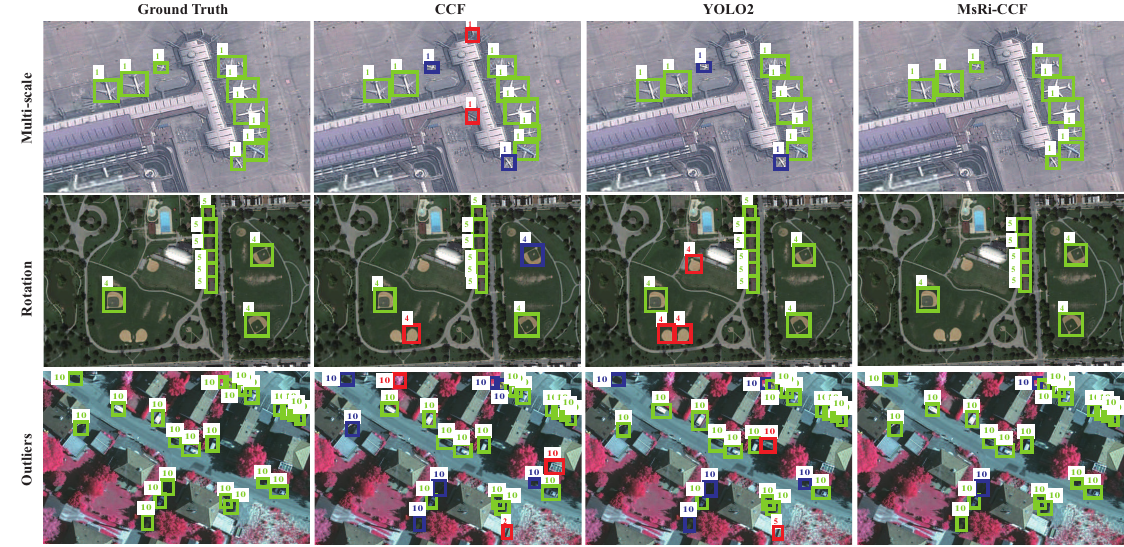
Figure 5. Visual comparison of three different methods (CCF, YOLO2, and MsRi-CCF) with regard to multi-scale, direction variation, and outliers.